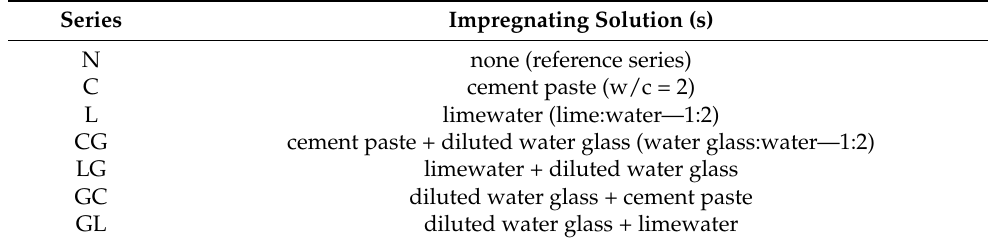
Table 2. Summary of the concrete series designations depending on the impregnating solutions used.